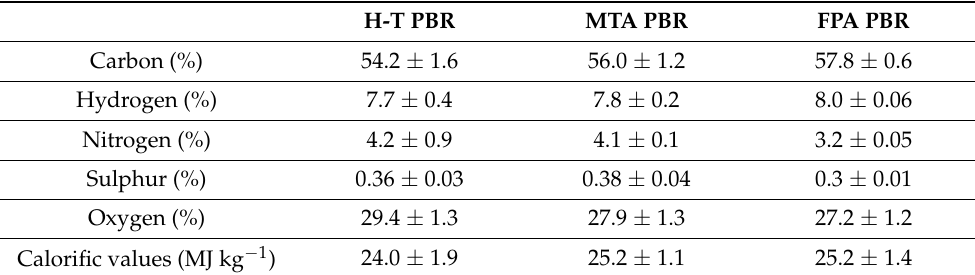
Table 2. Calorific values and the elemental analysis of C. pyrenoidosa biomass produced under nitro- gen limited conditions. The data represent averages ± standard deviations, n = 2–3. No differences between photobioreactors were identified (ANOVA followed by Tukey’s HSD test: p > 0.05).